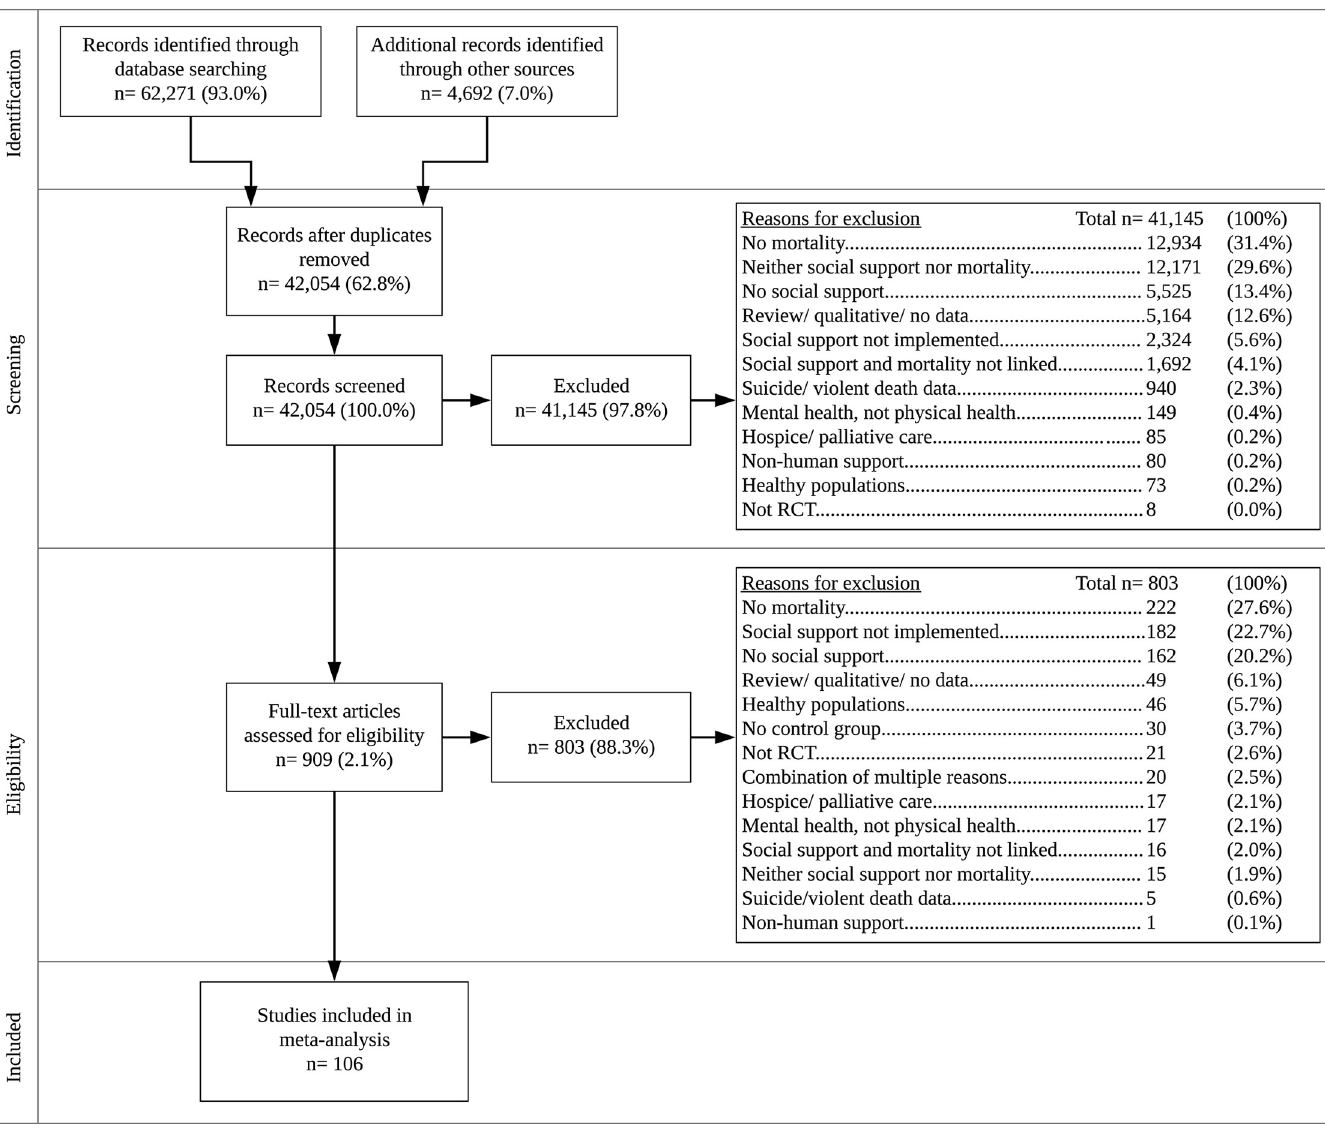
Fig 1 AU : AbbreviationlistshavebeencompiledforthoseusedthroughoutFigs 1 and 3 andTables 1 (cid:0) 4 : Pleaseverifythatallentriesarecorrect : . PRISMA flow diagram of study selection process. PRISMA, Preferred Reporting Items for Systematic Reviews and Meta-Analyses; RCT, randomized controlled trial.